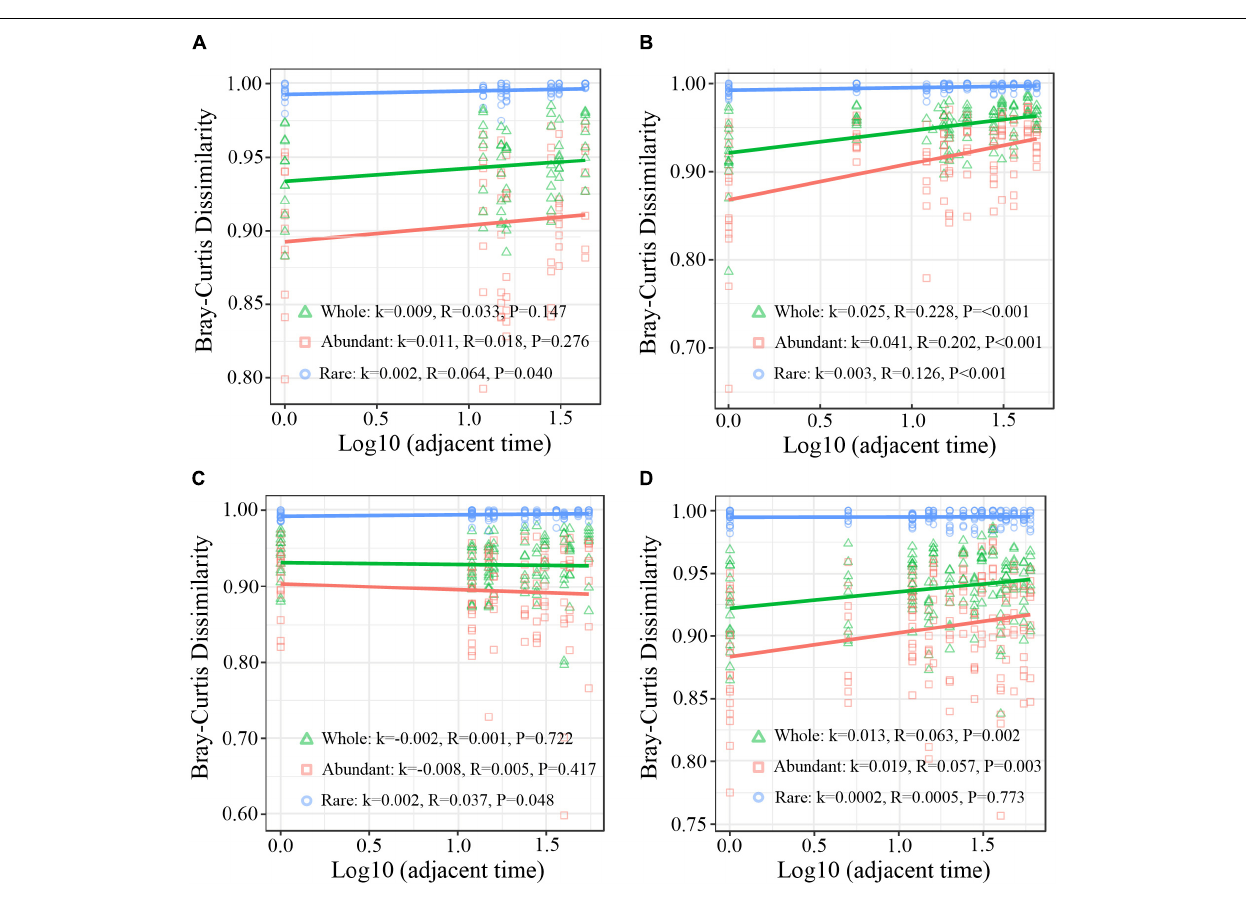
FIGURE 3 | Time-lag regression analysis of the relationship among sampling time and Bray–Curtis dissimilarity. (A) B sediment of the CON group (B) B sediment of the INV group (C) P sediment of the CON group (D) P sediment of the INV group. k , the regression slope; Whole, all bacterial community; Rare, rare taxa; Abundant, abundant taxa; CON, the control group; INV, the invasion